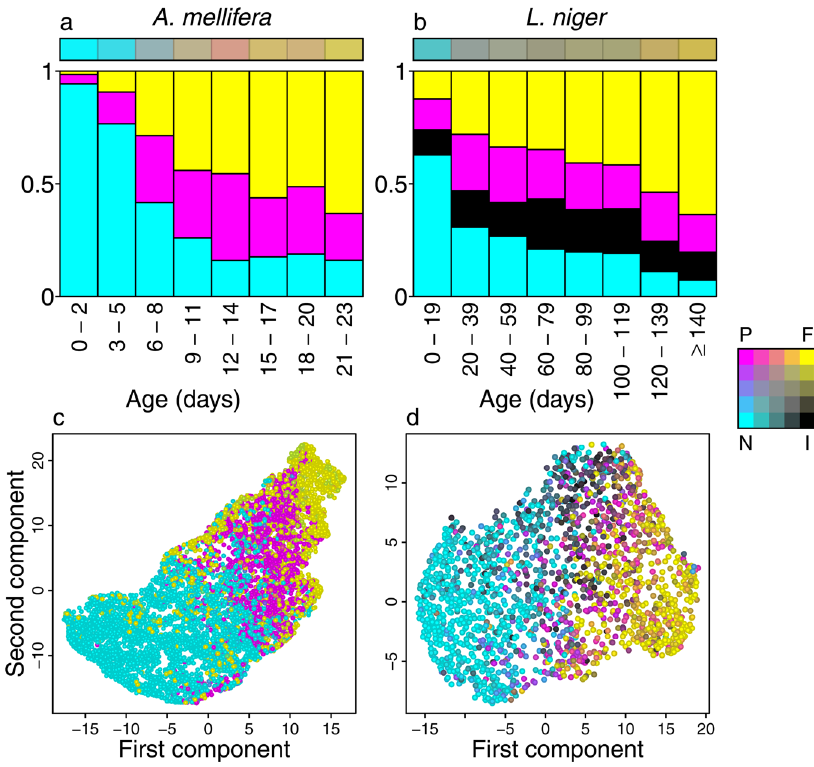
Fig. 2 | Correlations between age, module score and task validate the spatial approach. a , b Honeybee and ant workers exhibit similar transitions between modules as a function of age. Stacked bars indicate the average module score pro fi le for individuals of a given age. The horizontal bar encodes the typical module score pro fi le for individual of each age (CMYK combination of the scores for each module, averaged across all individuals of each age). c , d Workers belonging to different spatial modules exhibit different task pro fi les. Scatterplots